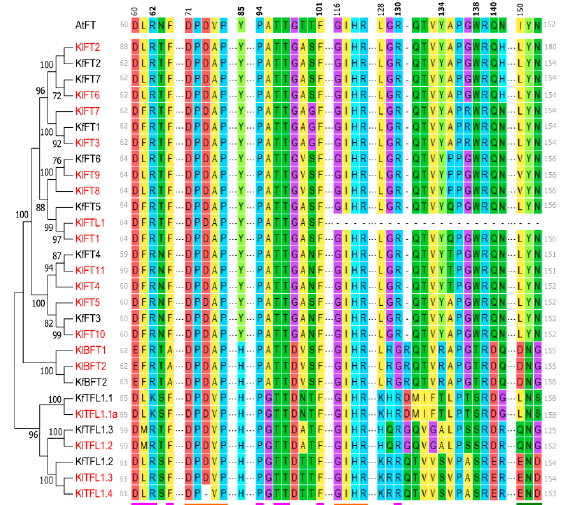
Figure 2. Amino acid alignment of deduced PEBP family protein sequences from Kalanchoë and Arabidopsis thaliana FT proteins. The colors indicate amino acids of different biochemical properties as obtained through MEGA 7.0. The sequences were aligned using ClustalW. Alignment of amino acid sequences of PEBP proteins at the 14-3-3 interaction interface is underlined in pink. The conserved DPDXP (Asp-Pro-Asp-X-Pro) and GIHR (Gly-Ile-His-Arg) motifs that compose anion-binding sites are underlined in orange. The conserved segment B (positions 128–141, exon 4) is underlined in blue and segment C (149–151, exon 4—XYN triad) is underlined in green. Amino acid positions indicated on the top of the sequence alignment are based on the Arabidopsis thaliana FT protein sequence BAA77838.1. Bold amino acid positions distinguish residues that are considered crucial for PEBP flowering inductive and repressive functions and 14-3-3 protein binding according to references [4,7–9,49]. In the present alignment arginine at position 62 (R62), proline at position 94 (P94), phenylalanine at position 101 (F101), and arginine at position 140 (R130) are predicted to participate in binding between PEBP proteins and 14-3-3 proteins. Tyrosine at position 85 (Y85) is present in all FT-like proteins, while histidine at position 85 (H85) is present in TFL1 -like proteins. FT-like proteins contain tyrosine at position 134 (Y134), while TFL1 -like proteins contain non-tyrosine amino acids. All FT-like proteins contain tryptophan at position 138 (W138), while TFL1 -like contain non-tryptophan amino acids. At position 140, FT-like proteins contain glutamine (Q140), while TFL1 -like proteins contain aspartic acid (D140) or glutamic acid (E140).